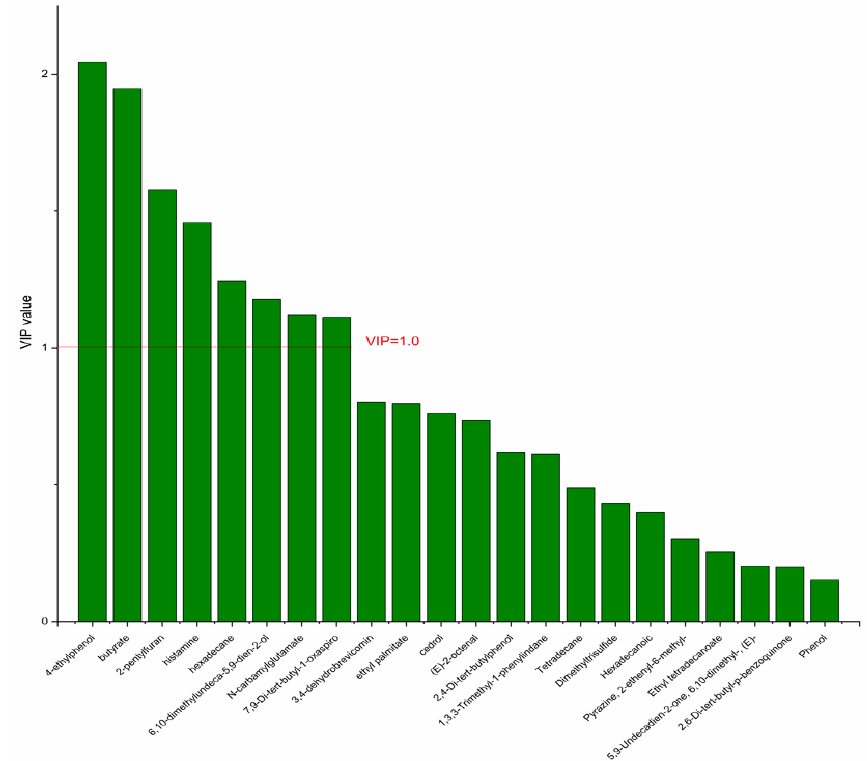
Figure 13. The VIP plot of the differential bacterial metabolites in DPA group vs. HC group.